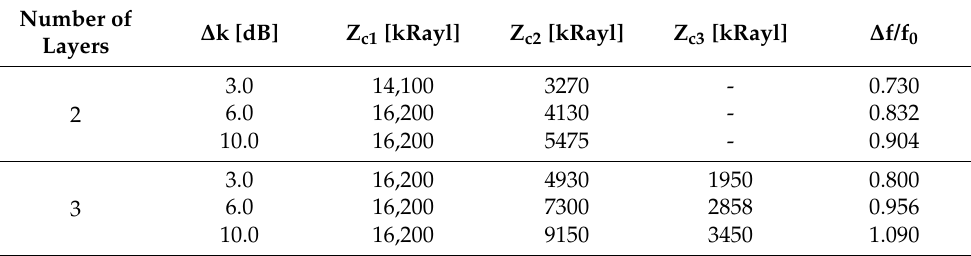
Table 3. Acoustic impedances of the matching layers obtained with the genetic algorithm (water, Z T Z T = 1500 kRayl, the impact of ∆ k = 1500 kRayl , the impact of Δk coefficient).